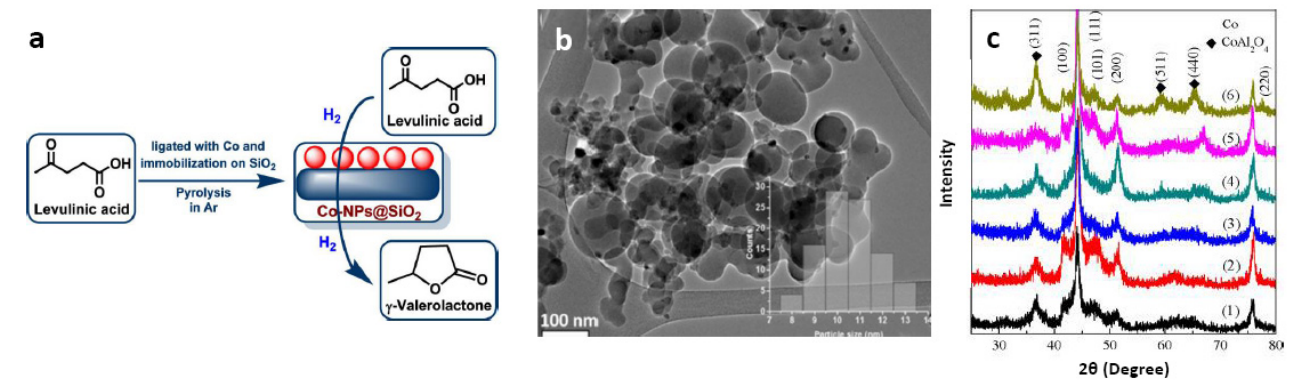
Figure 3. ( a ) Valorization of LA for the preparation of cobalt ‐ based nanocatalysts and GVL. ( b ) TEM image of Co–LA@SiO 2 –800. Reproduced with permission from Reference [56]. Copyright 2019, American Chemical Society. ( c ) XRD patterns of samples reduced with H 2 including (1) 5Co/Al 2 O 3 , (2) 4Co/Al 2 O 3 , (3) 3Co/Al 2 O 3 , (4) 2Co/Al 2 O 3 , (5) 1Co/Al 2 O 3 and (6) spent 4Co/Al 2 O 3 . Reproduced with permission from Reference [58]. Copyright 2015, Elsevier Ltd. Table 1. Single non ‐ precious metal catalysts for the hydrogenation of LA to GVL.